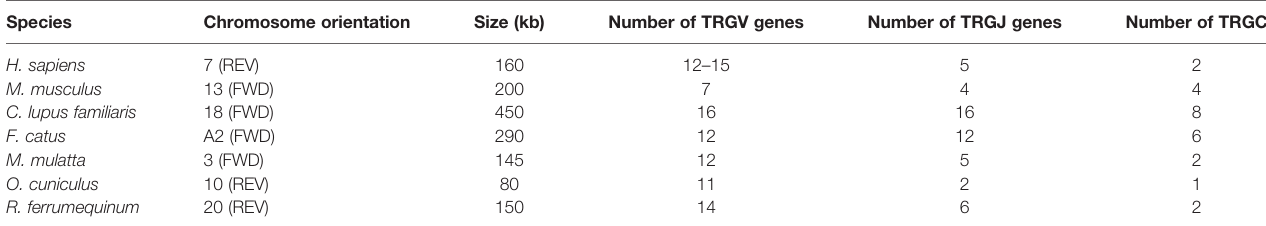
TABLE 2 | Statistical analysis of TRG loci in humans ( Homo sapiens ), mice ( Mus musculus ), dogs ( Canis lupus familiaris ), cats ( Felis catus ), rhesus monkeys ( Macaca mulatta ), rabbits ( Oryctolagus cuniculus ), and bats ( Rhinolophus ferrumequinum ).